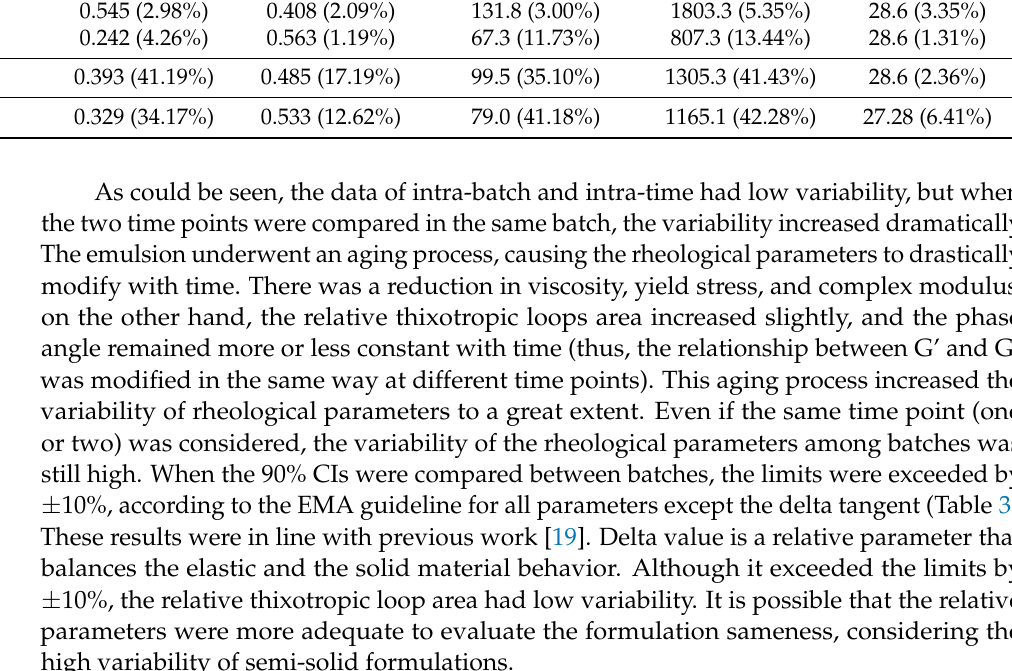
Table 2. Rheological profile of three batches 0.025% w / w capsaicin emulsions. Table shows mean value, and values in brackets show the relative standard deviation (CV%). η : viscosity. RTLA: rela- tive thixotropic loop area, G*: complex modulus. δ : phase angle of delta tangent.